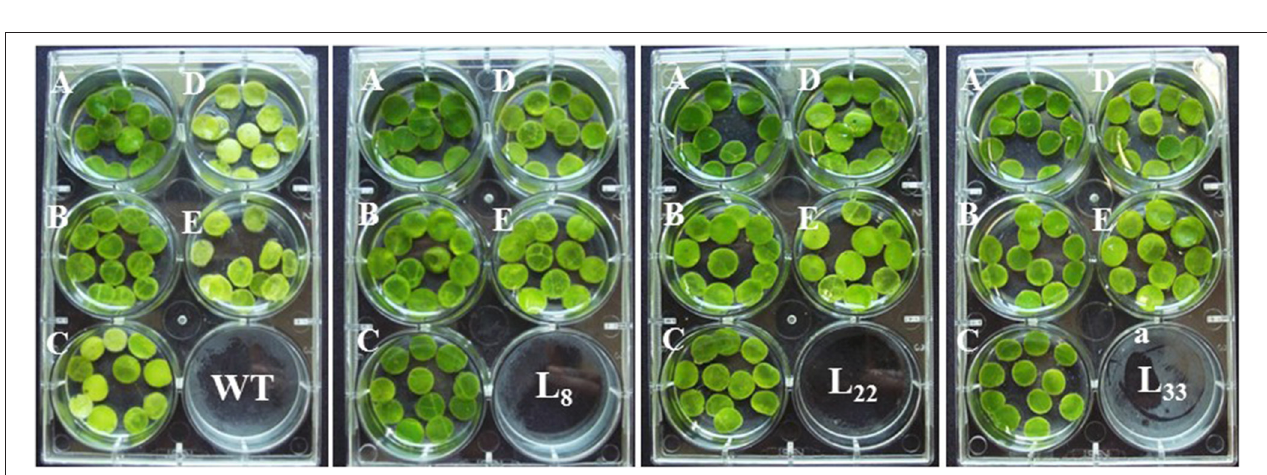
FIGURE 4 | Leaf disc assay of WT and transgenic tobacco under control (A) and salt ( B –100 mM, C –150 mM, D –200 mM NaCl) and drought ( E –10% PEG) conditions.